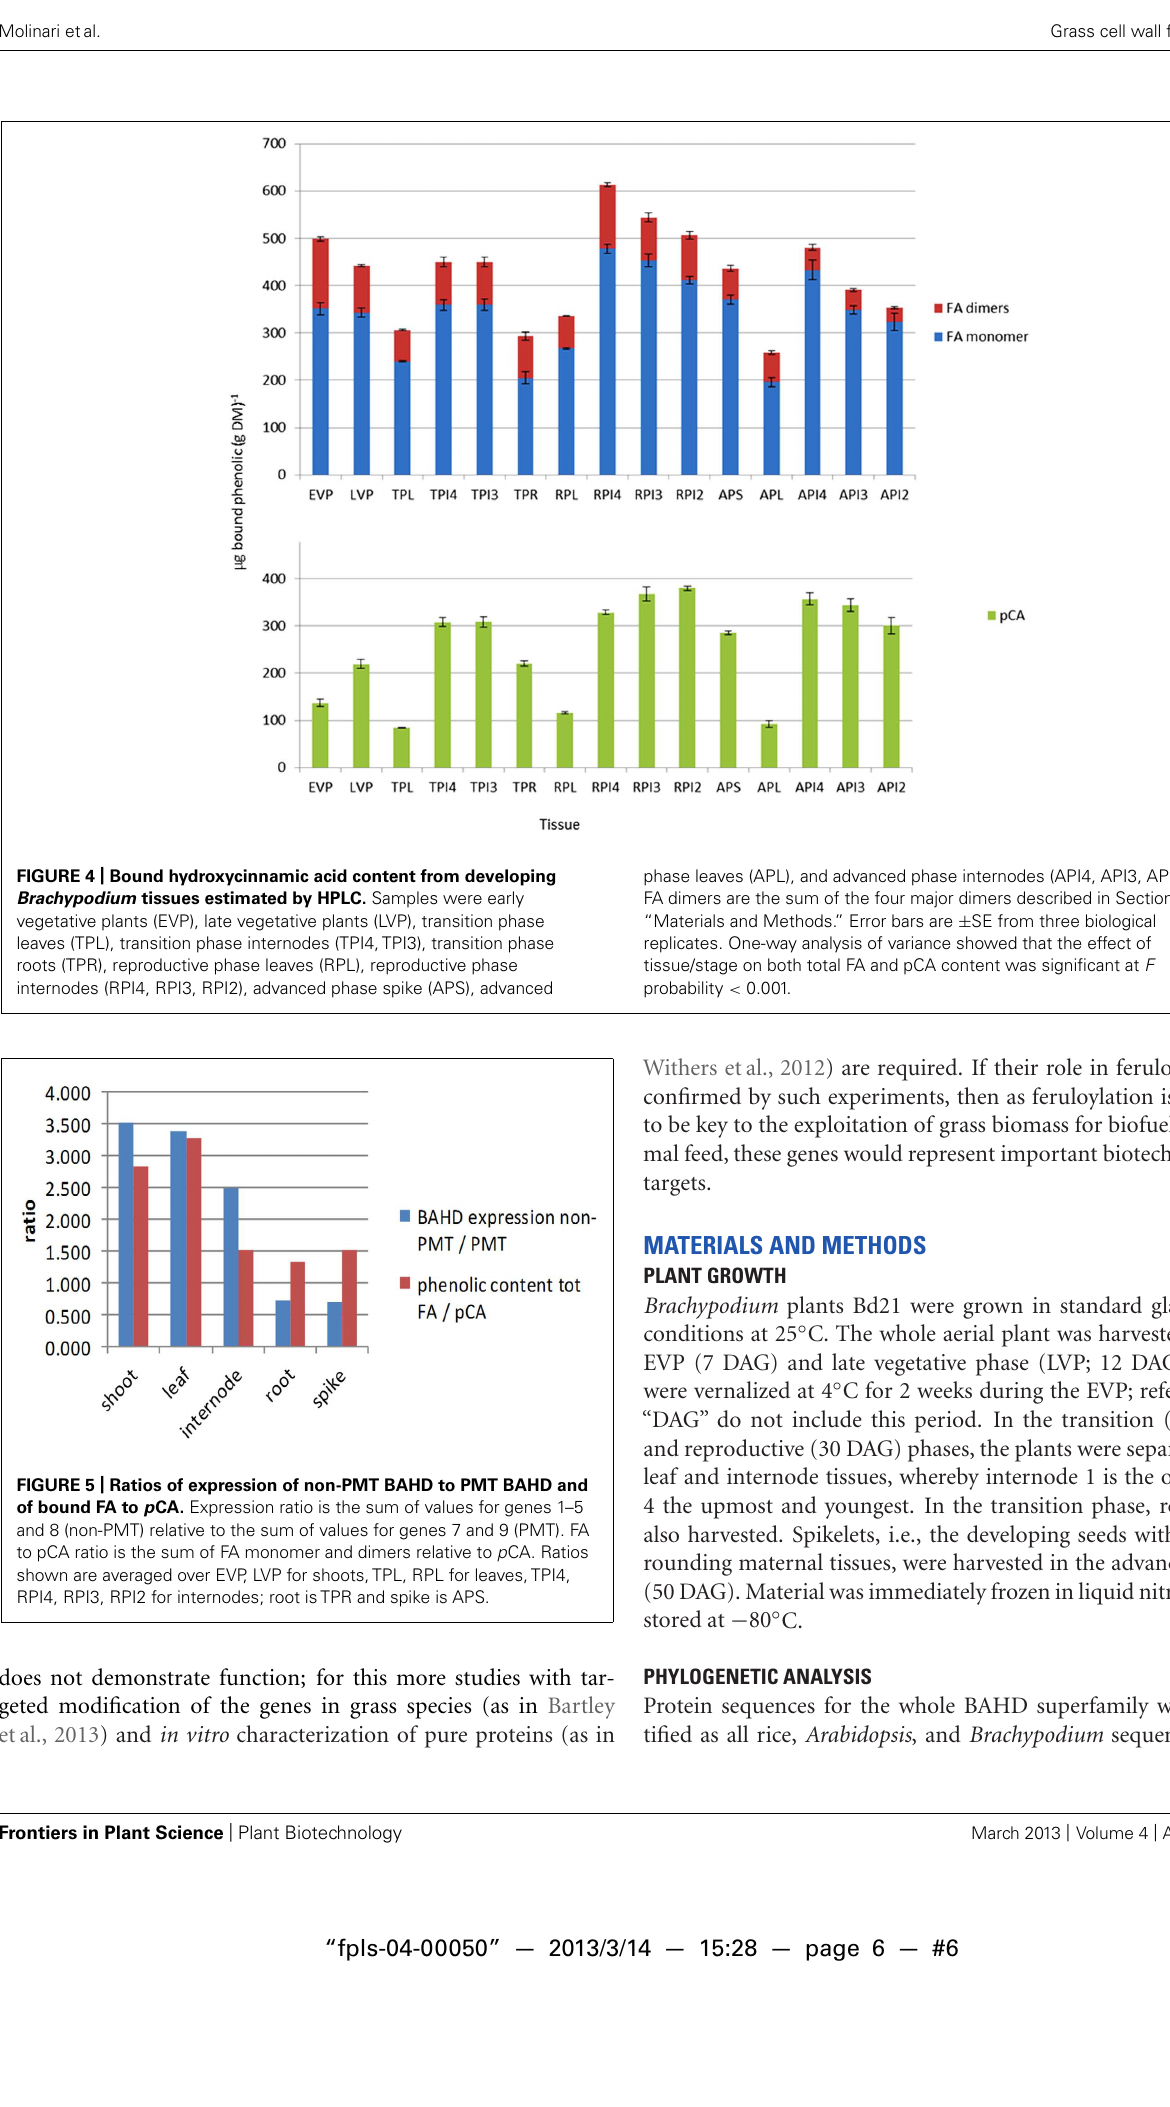
does not demonstrate function; for this more studies with